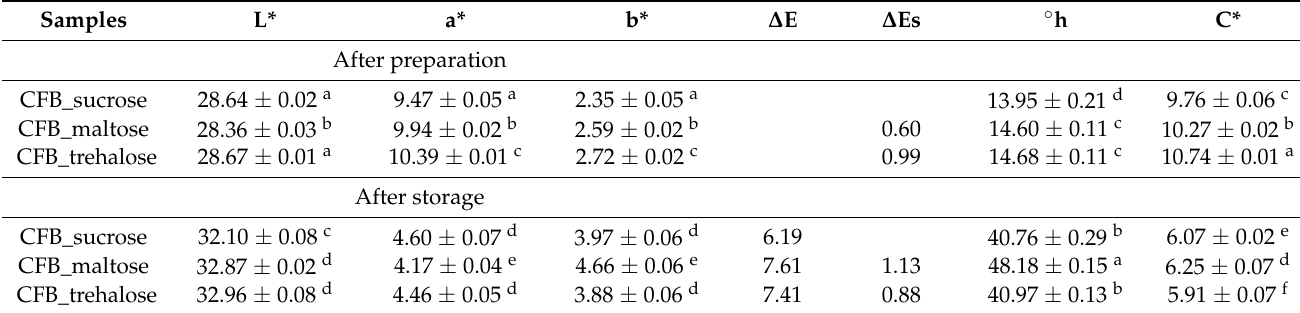
Table 3. Color parameters (L*, a*, b*, ◦ h and C*) of citrus fiber-blackberry cream fillings after preparation and after storage at room temperature for three months.